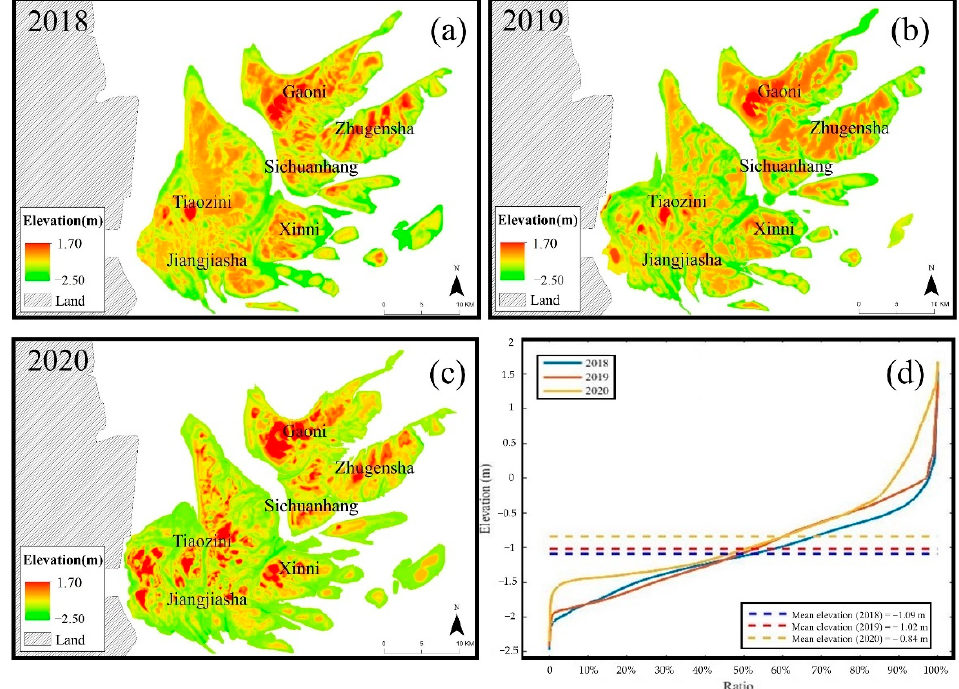
Figure 3. DEMs of the study area for 2018 − 2020 using the methods described above. (( a − c ) DEM construction results for each year; ( d ) DEM elevation frequency histogram results for each year.)